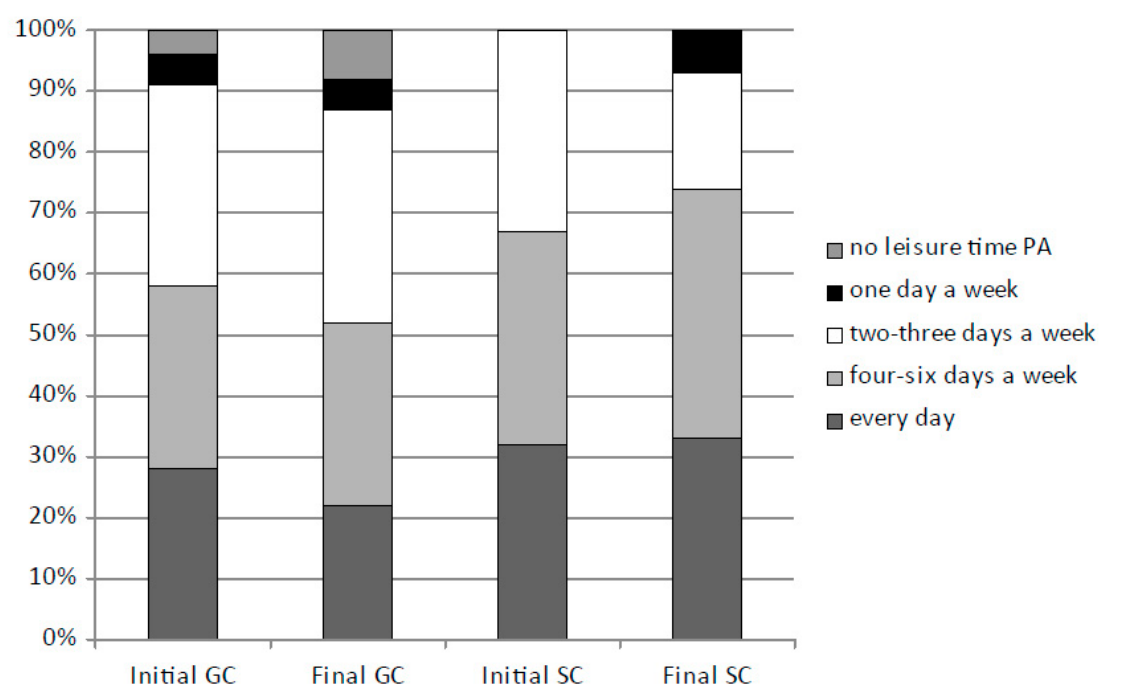
Figure 2. Comparison of frequency of leisure time PA between the initial (2017) and the final (2019) assessment sessions, %. GC—control group of standard PA at school (4 h a week); SC—increased PA at school (10 h a week).